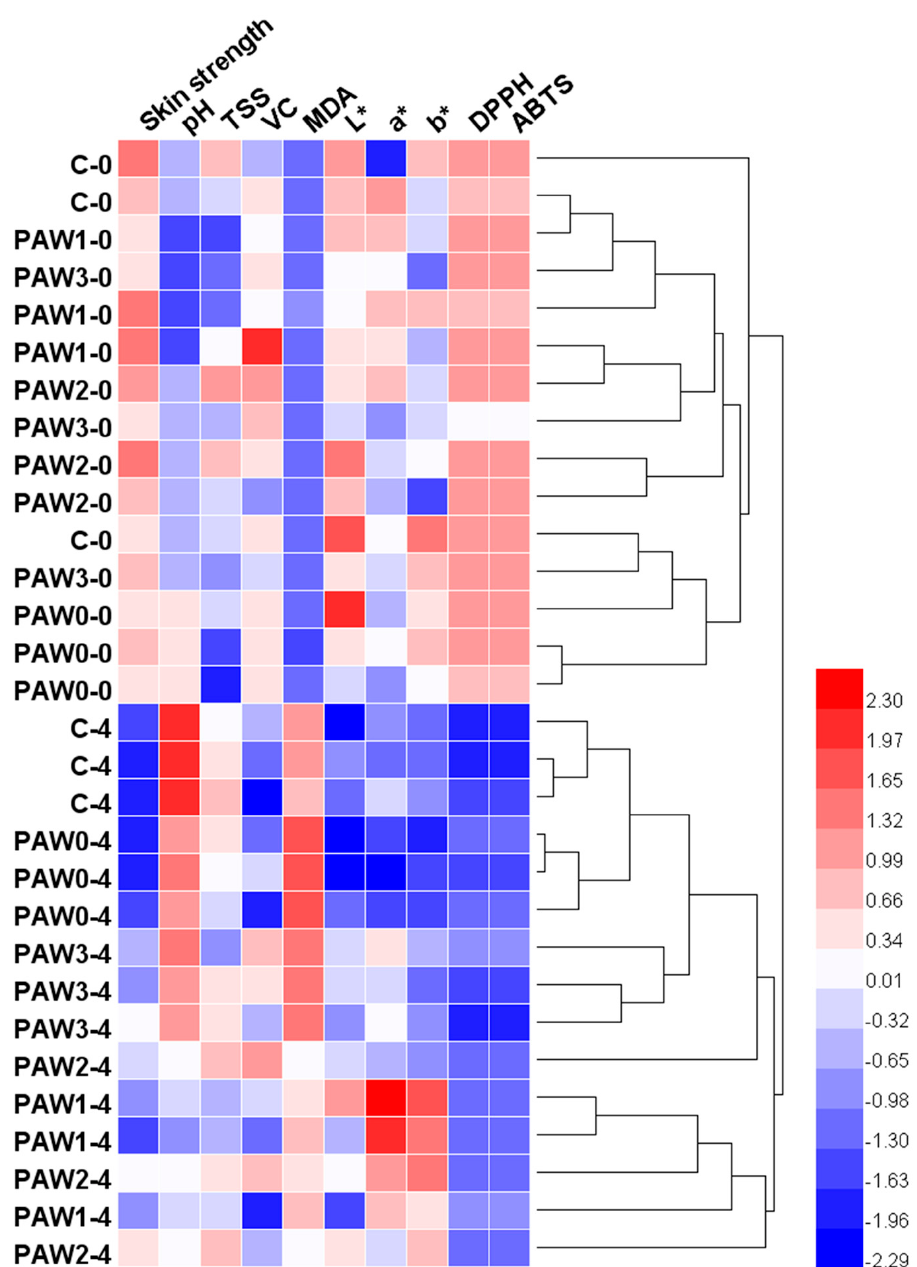
Figure 4. Heatmap combined with the dendrogram of cluster analysis based on the quality of straw- berries.